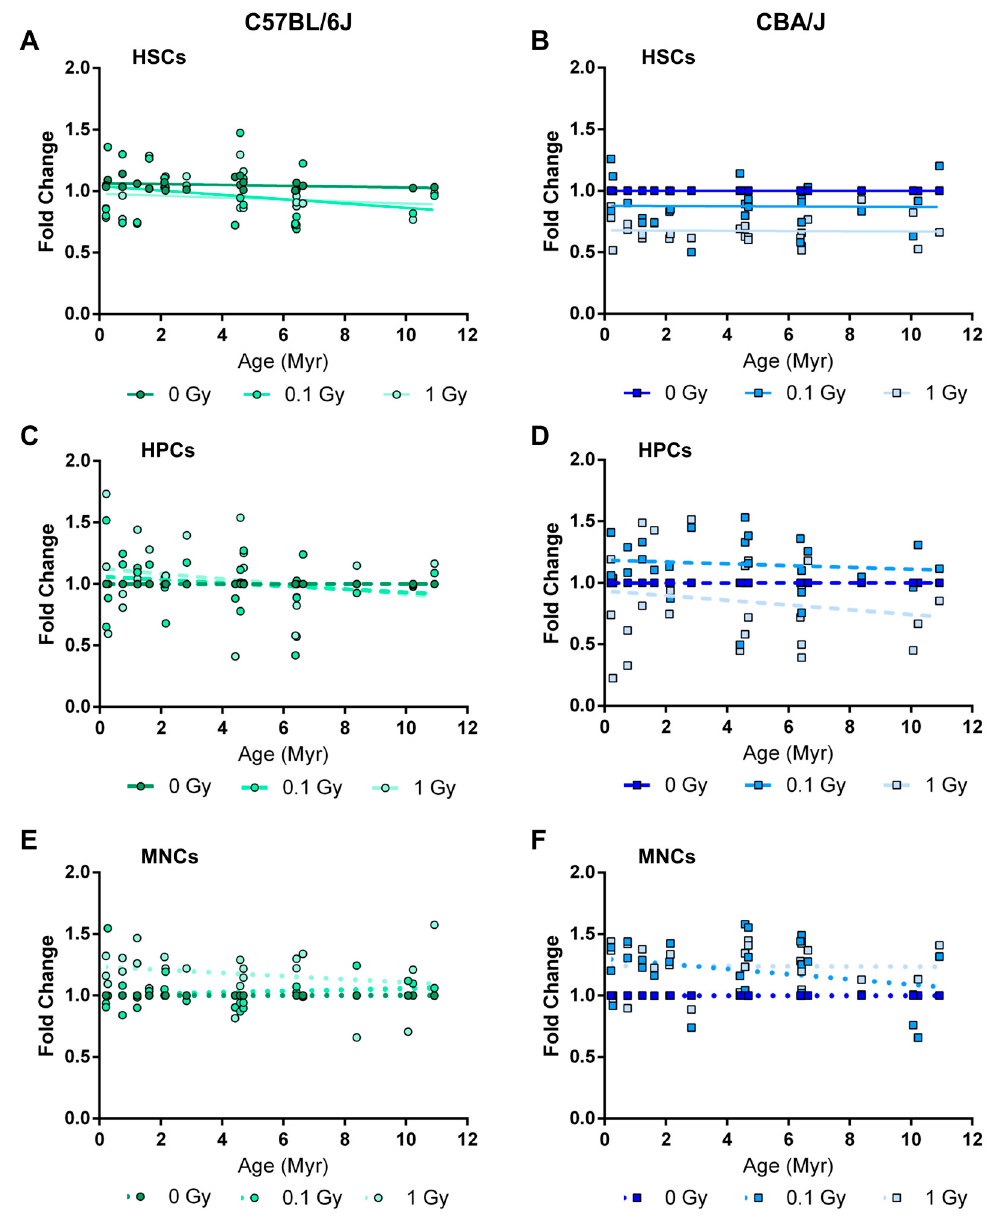
Figure 5. Comparative analysis of LINE-1 DNA methylation in the hematopoietic system of C57BL/6J and CBA/J mice in response to low-dose radiation. LINE-1 DNA methylation was analyzed in ( A , B ) hematopoietic stem cells, ( C , D ) hematopoietic progenitor cells, and ( E , F ) mononuclear cells in C57BL/6J ( A , C , E ) and CBA/J ( B , D , F ). Sham-irradiated samples (0 Gy) were arbitrarily given a value of 1 for the purpose of comparison ( n = 5/group). Myr: million years.